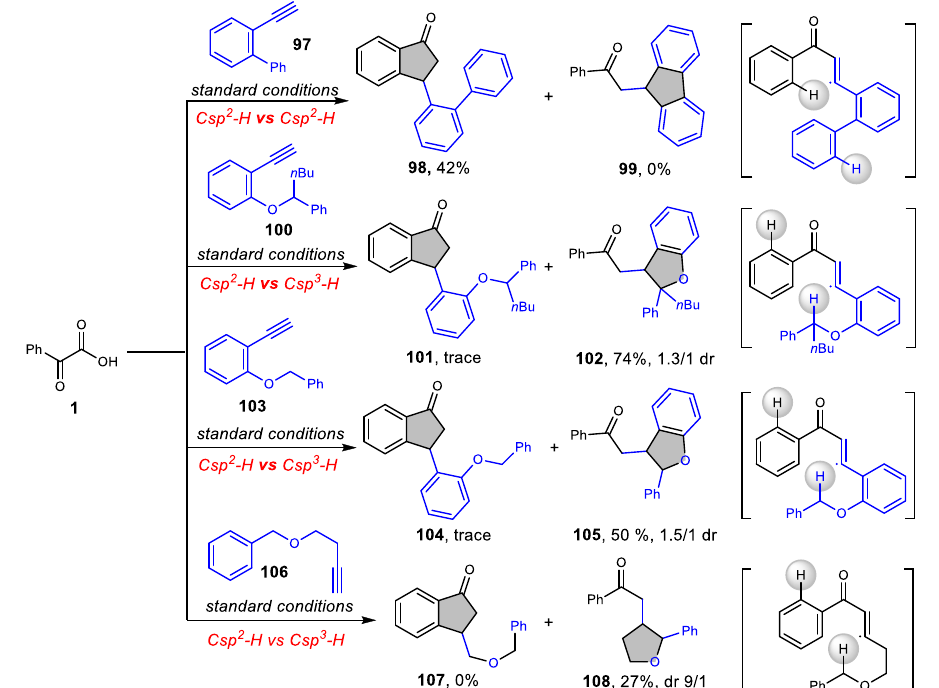
Fig. 7 Mechanistic probes for chemo- and regio-selectivity. Competitions between different C – H bonds. The indanone 98 was formed in the presence of another C sp 2 – H bond. Only furan-derived products ( 102 , 105 and 108 ) could be isolated when weaker C sp 3 – H bonds have existed.